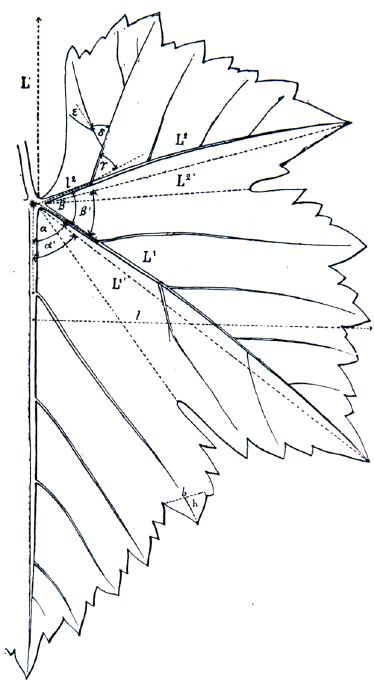
Figure 2. Leaf venation by Ravaz (1902)